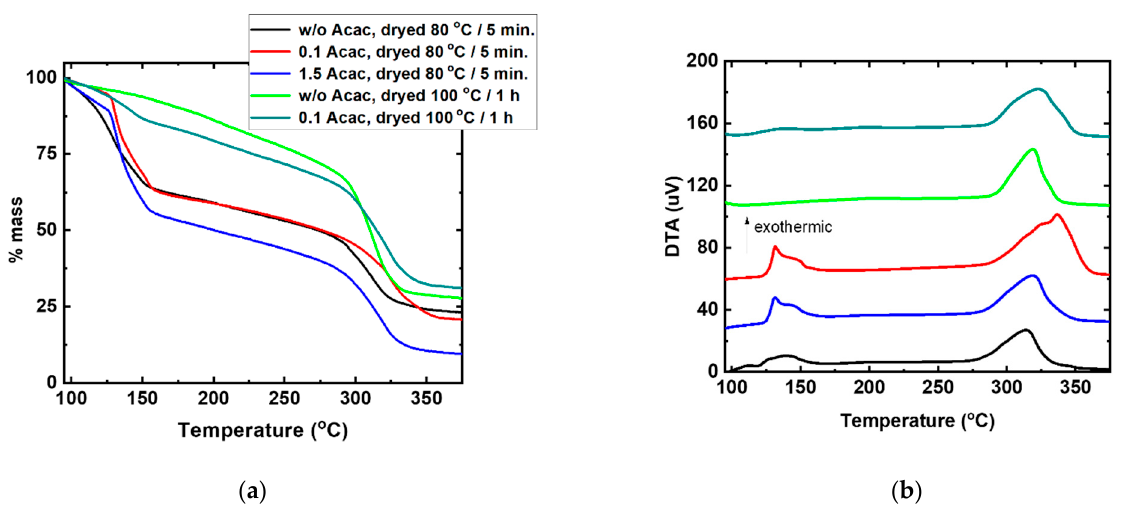
Figure 2. ( a ) TGA curves of precursor films without (w/o) fuel and containing 0.1 and 1.5 molar ratio of fuel (Acac) to oxidizer (Cu, Ni nitrates) in 2 ‐ methoxy ethanol dried at 80 and 100 °C, and ( b ) the respective DTA curves.